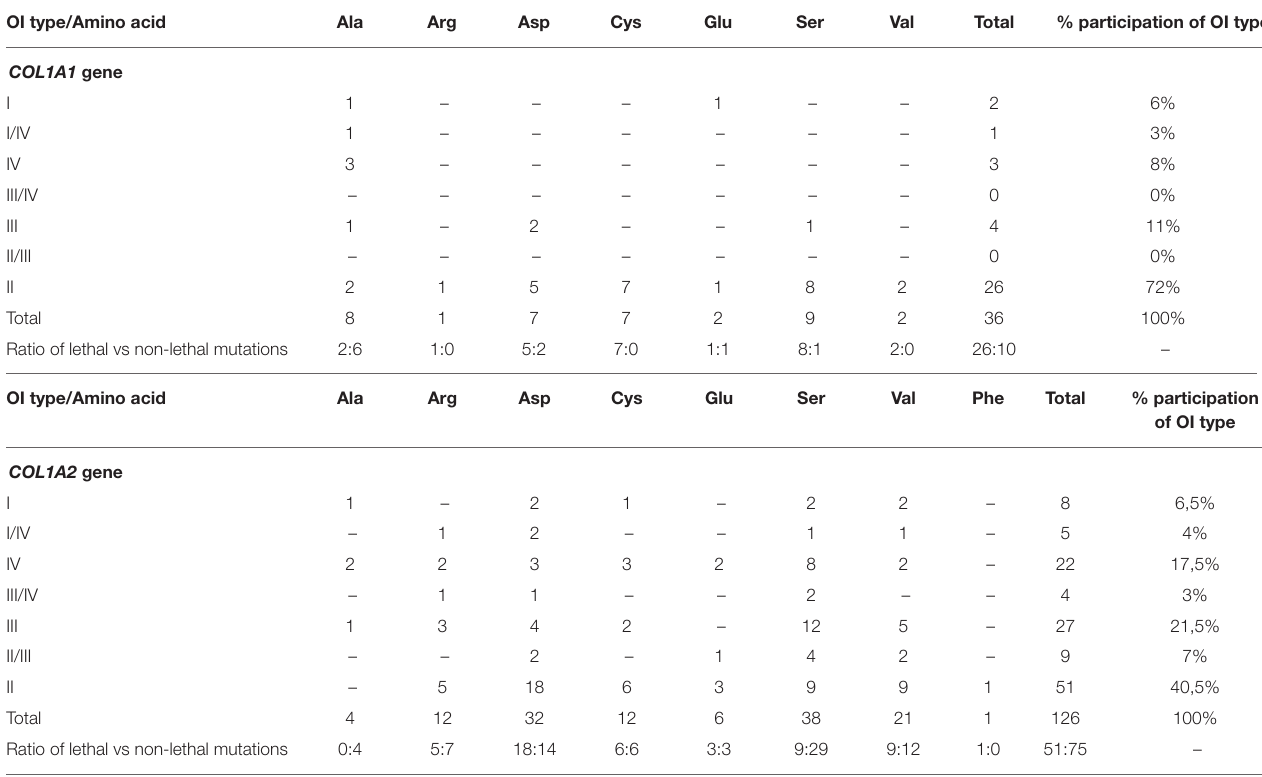
The odds the mutations being lethal for each residue is